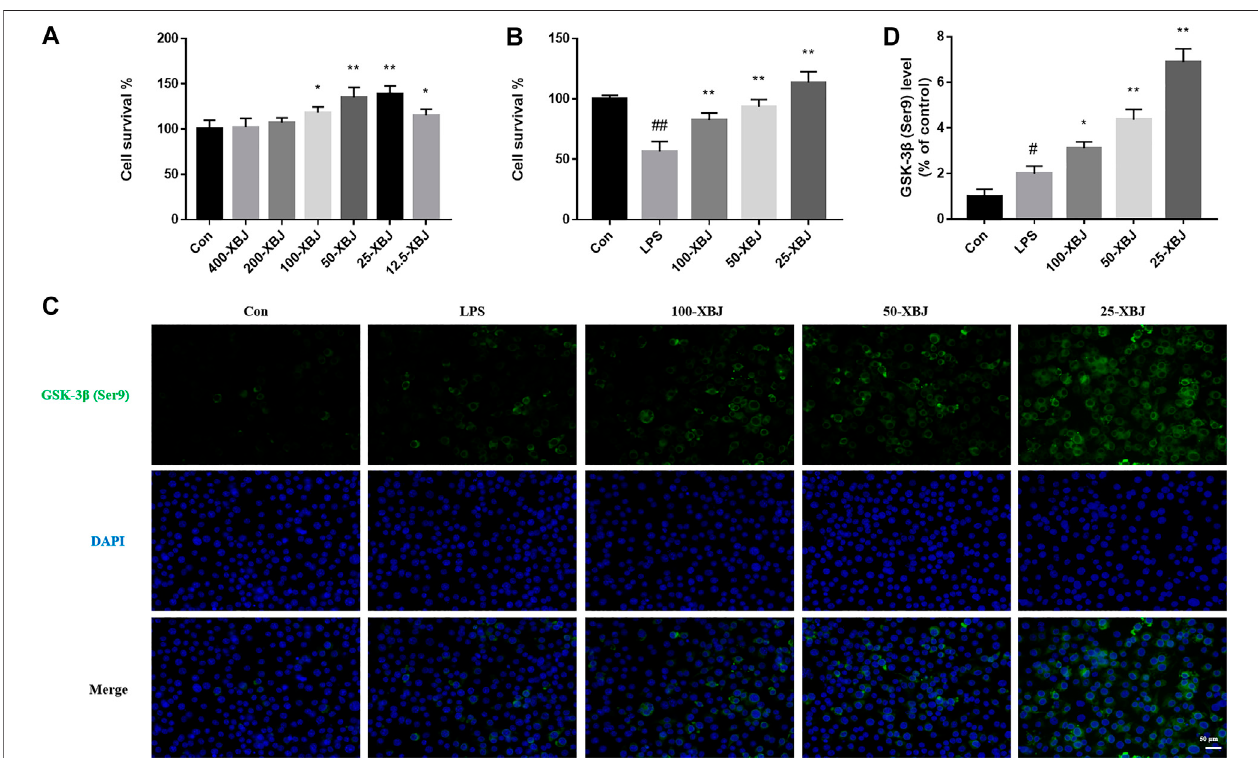
FIGURE 5 | XBJ treatment increases the viability and GSK-3 β (Ser9) expression of RAW264.7 cells (A) Concentration screening for XBJ cell experiments. (B) XBJ improved the viability of LPS-induced sepsis ALI cells (C) Representative images of GSK-3 β immuno fl uorescence in vitro . (D) The expression of GSK-3 β in cell with ALI. Con:controlgroupwithoutLPStreatment;LPS:modelgroupwithLPStreatment;100-XBJ:groupwithLPStreatment +XBJinjectiondiluted100times;50-XBJ:group with LPS treatment + XBJ injection diluted 50 times; 25-XBJ: group with LPS treatment + XBJ injection diluted 25 times. Compared with the control group, # p < 0.05, ## p < 0.01 were considered to be signi fi cant; Compared with the CLP group, * p < 0.05, ** p < 0.01 were considered to be signi fi cant. Data are expressed as mean ±